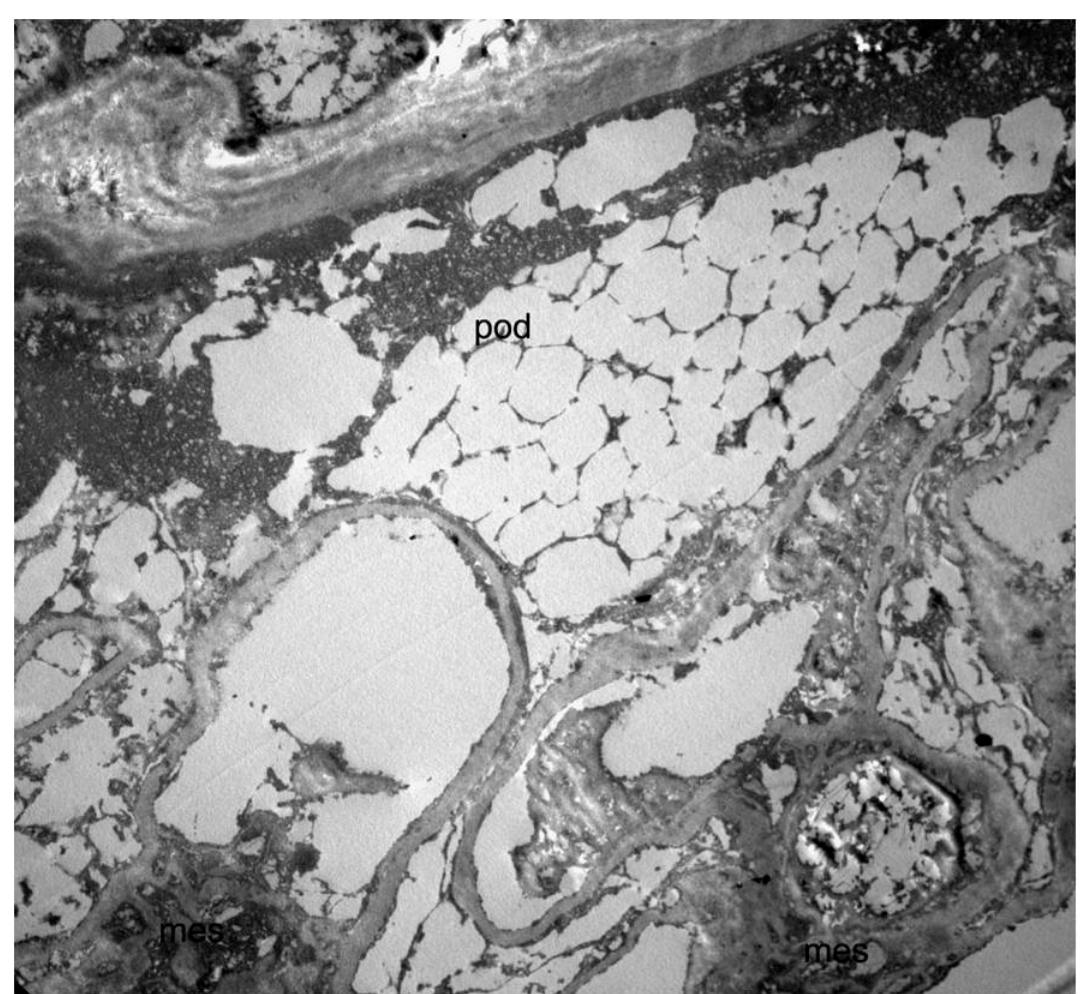
Figure 2. Transmission electron microscopy image of the kidney biopsy (10 × 3000), showing a multivacuolized appearance of a podocyte (pod). Since the analysis in electron microscopy was carried out on a fragment of renal tissue recovered from paraffin (and not on a standard glutaraldehyde fixed preparation), the overall structural detail was poorly preserved, and glycosphingolipid deposits could not be directly visualized due to the extraction of the lipid components. This resulted in a multivacuolized appearance of the podocytes that, although not strictly diagnostic, was compatible with the diagnosis of Fabry